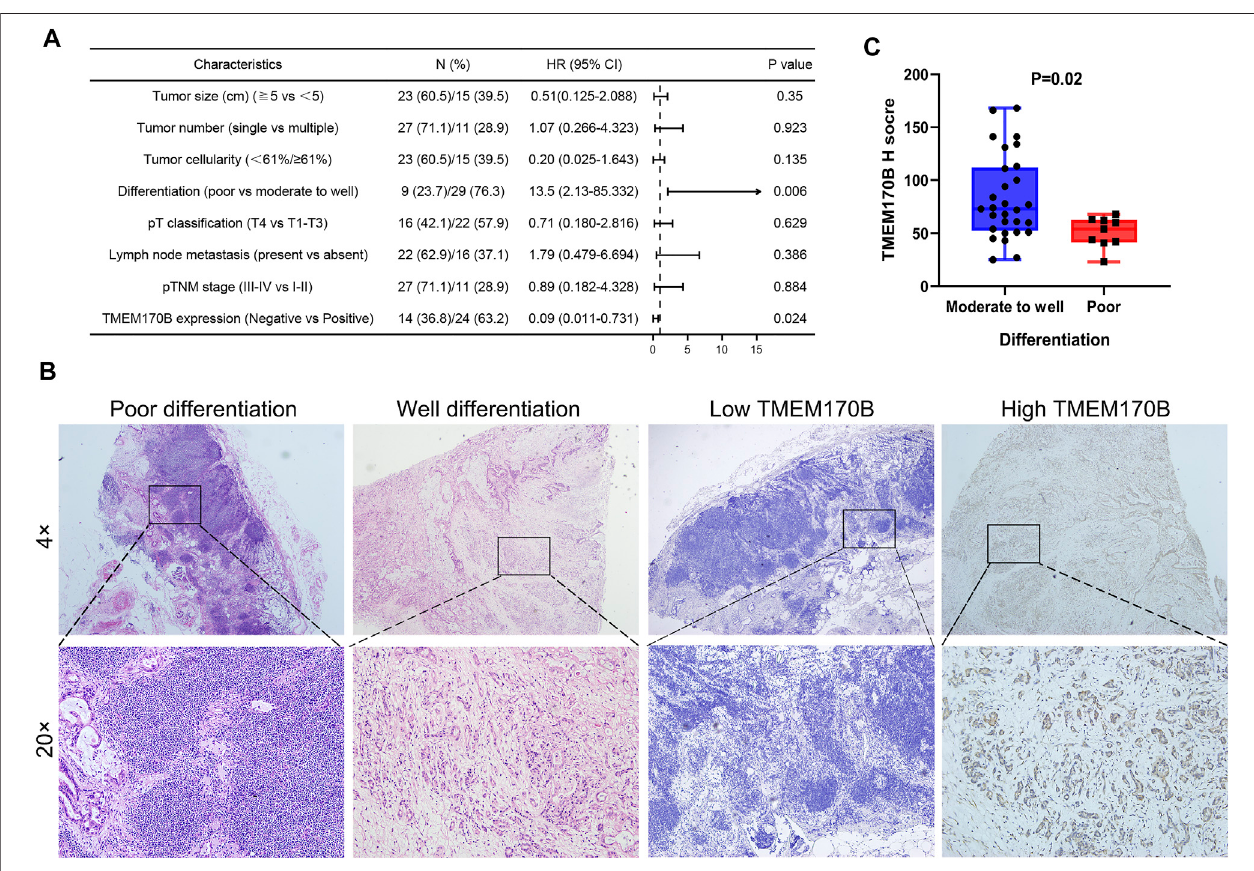
FIGURE 4 | Correlation of TMEM170B expression with the degree of differentiation in PAAD. (A) The Cox regression analysis of the forecast factors of OS by univariateanalysis. (B) ThehistopathologicalcomparisonofthedegreesofdifferentiationandTMEM170Bexpressionofthesamespecimen. (C) TMEM170BExpression in Moderate to well differentiation group and poor